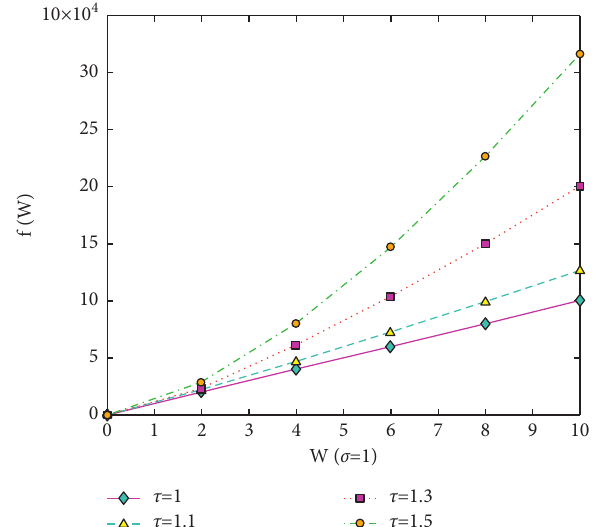
Figure 2: Influence of parameter change on congestion cost function ( σ � 1 )